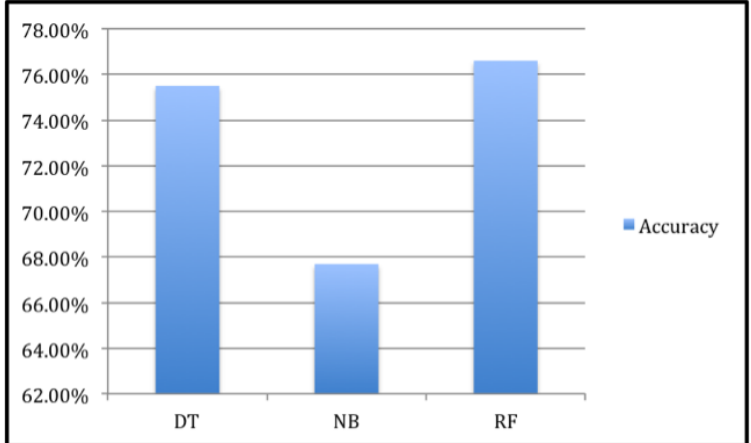
Figure 10. The accuracy for traditional DM